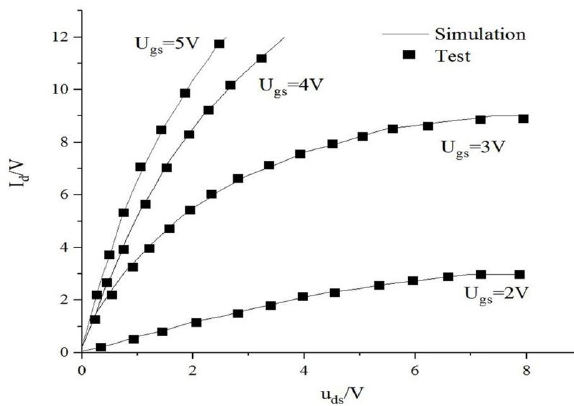
Figure 2: Simulation and test results of GaN power transistor output characteristics